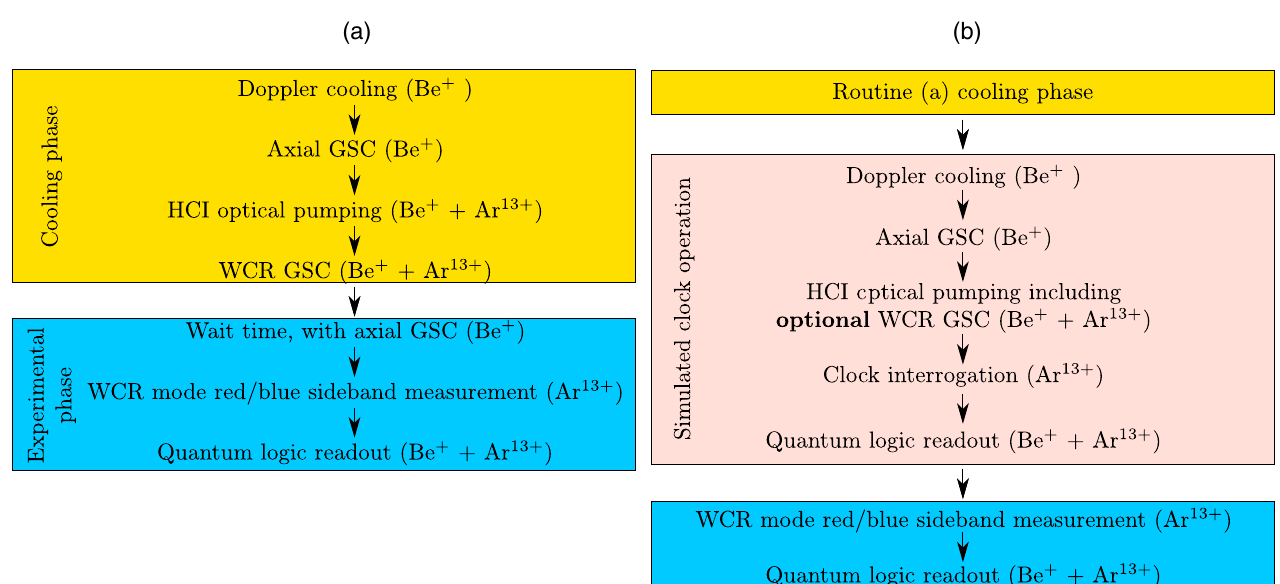
FIG. 7. Simplified depiction of the two main experimental sequences used in this work, with the cooling phases (yellow), clock operation (pink), and experimental (blue) phases indicated.The ions involved in each step are also indicated. Sequence (a) was used to measure anomalous heating rates for the WCR modes, Rabi flopping, and for sideband scans. Sequence (b) was used to demonstrate suppression of the heating of the WCR modes during simulated clock operation, as displayed in Fig. 5, with the central clock operation section repeated a variable number of times in order to measure the evolution of the WCR mode temperature over an increasing number of cycles. Abbreviation : GSC — ground-state